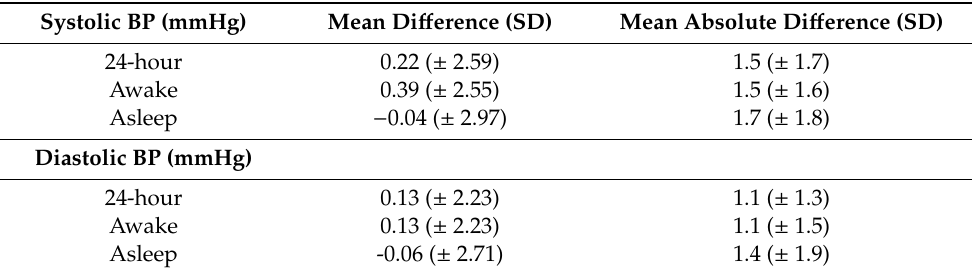
Table 5. Mean blood pressure di ff erences and mean absolute blood pressure di ff erences comparing blood pressure values generated by DominoBP and SchillerBP software.